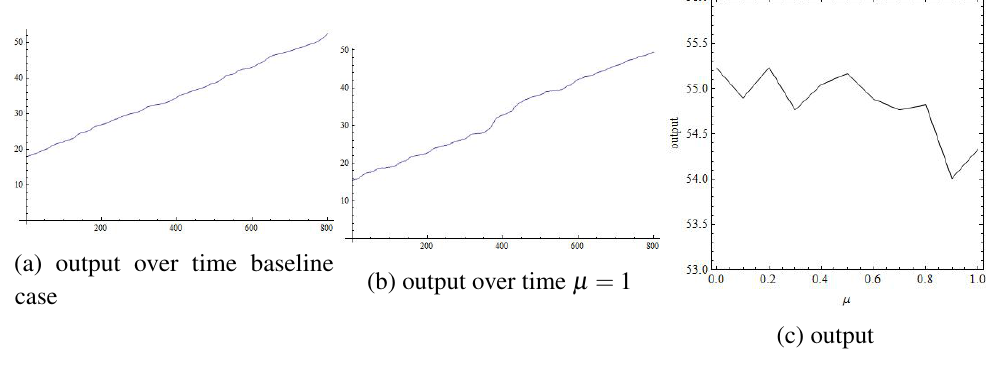
Figure 1: Impact of µ on output